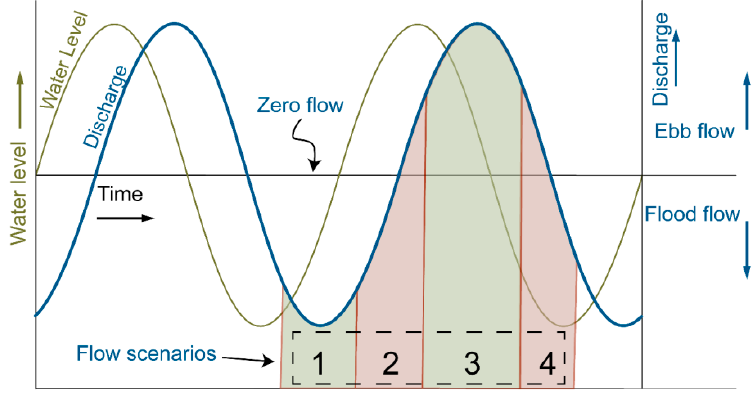
Figure 6. Schematic of flow scenarios used for studying the hydrodynamics of tidal confluences.